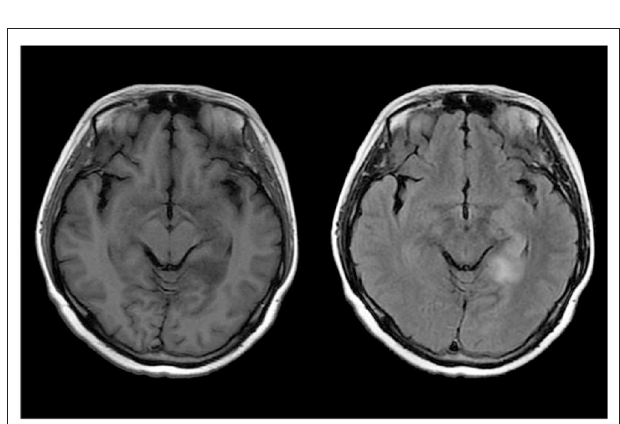
FIGURE 2 | Neuroradiologic MRI (3.0T) of Patient 2. The left temporal lobe and hippocampus showed hypointensity on T1WI and hyperintensity on FLAIR.